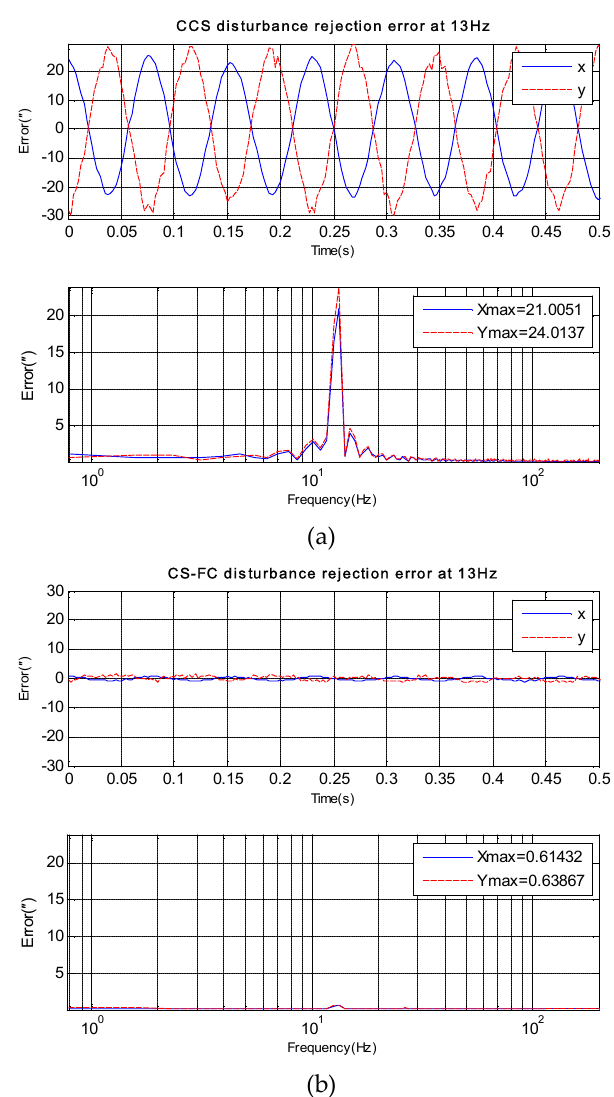
Figure 7. X -axis and Y -axis disturbance rejection error at 13 Hz. ( a ) disturbance rejection error of CCS; ( b ) disturbance rejection error of CS-FC.